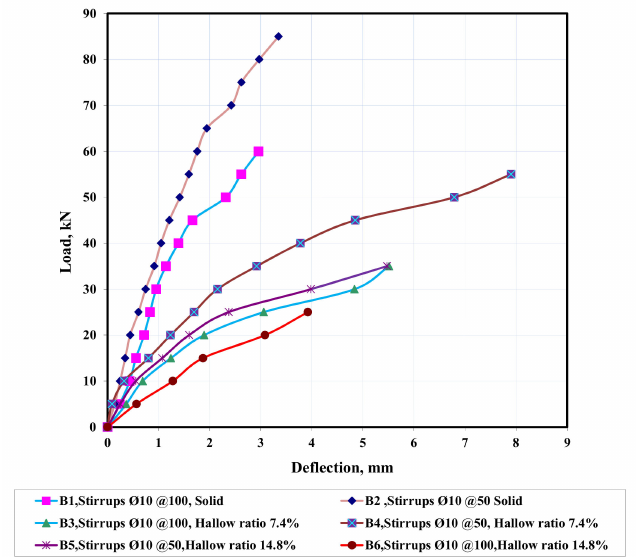
Figure 16. Numerical simulation results of the load-deflection curves at mid-span for all the RC beam models.